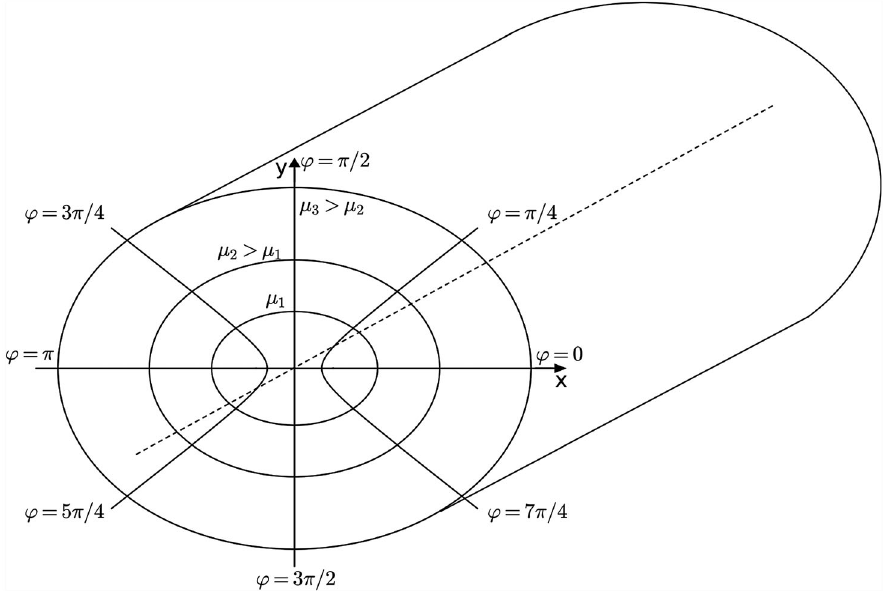
FIG. 1. Elliptical coordinates. The φ coordinate describes a series of hyperbolas having the same foci. The μ coordinate describes confocal ellipses centered in the origin of the coordinate